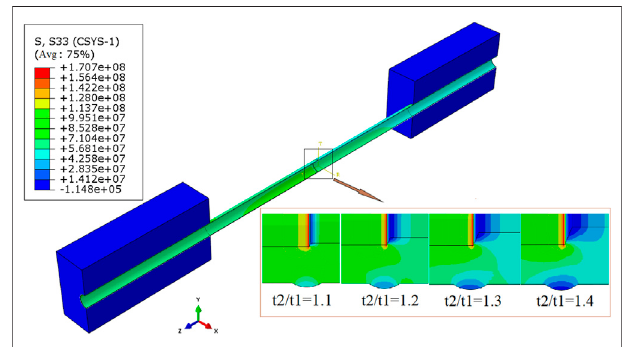
FIGURE 7 | Stress nephogram in fl uenced by wall thickness ratio.